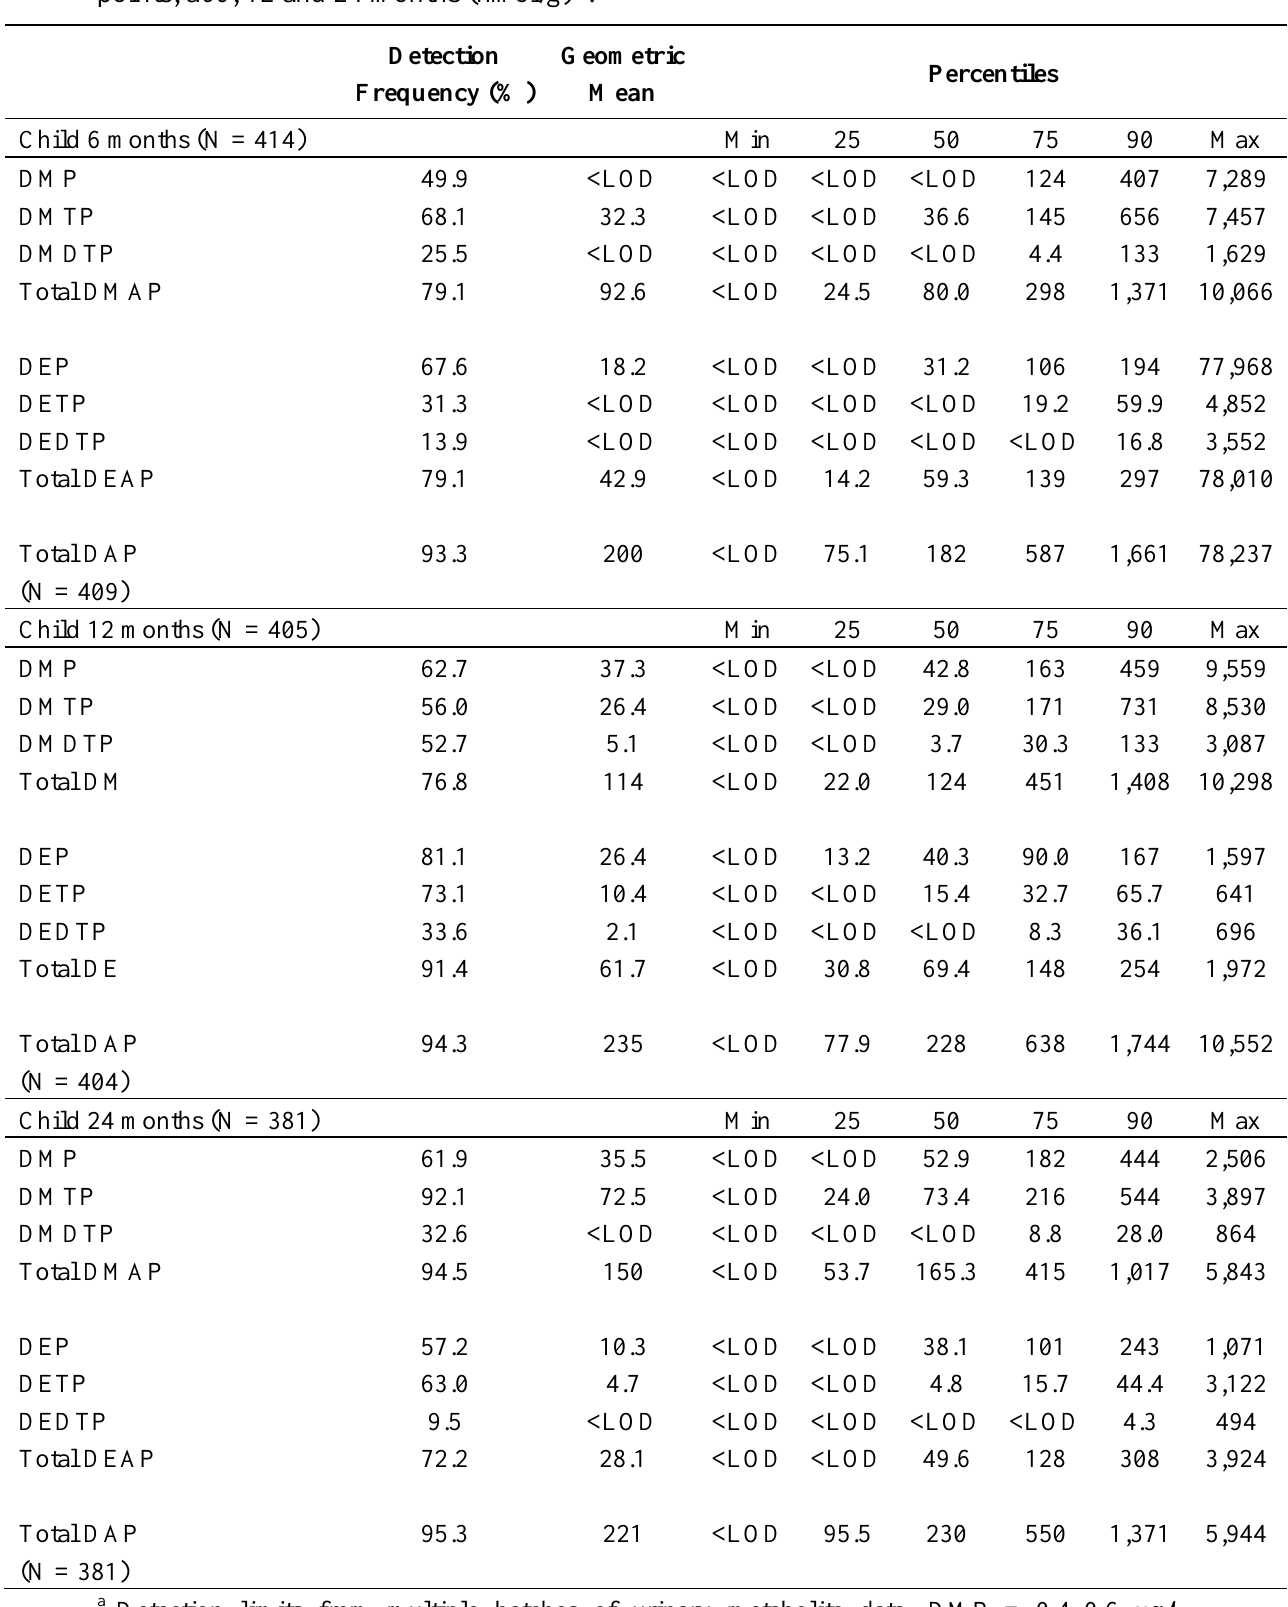
Table S2. Children’s creatinine-adjusted urinary DAP metabolite levels at three time points, at 6, 12 and 24 months (nmol/g) a